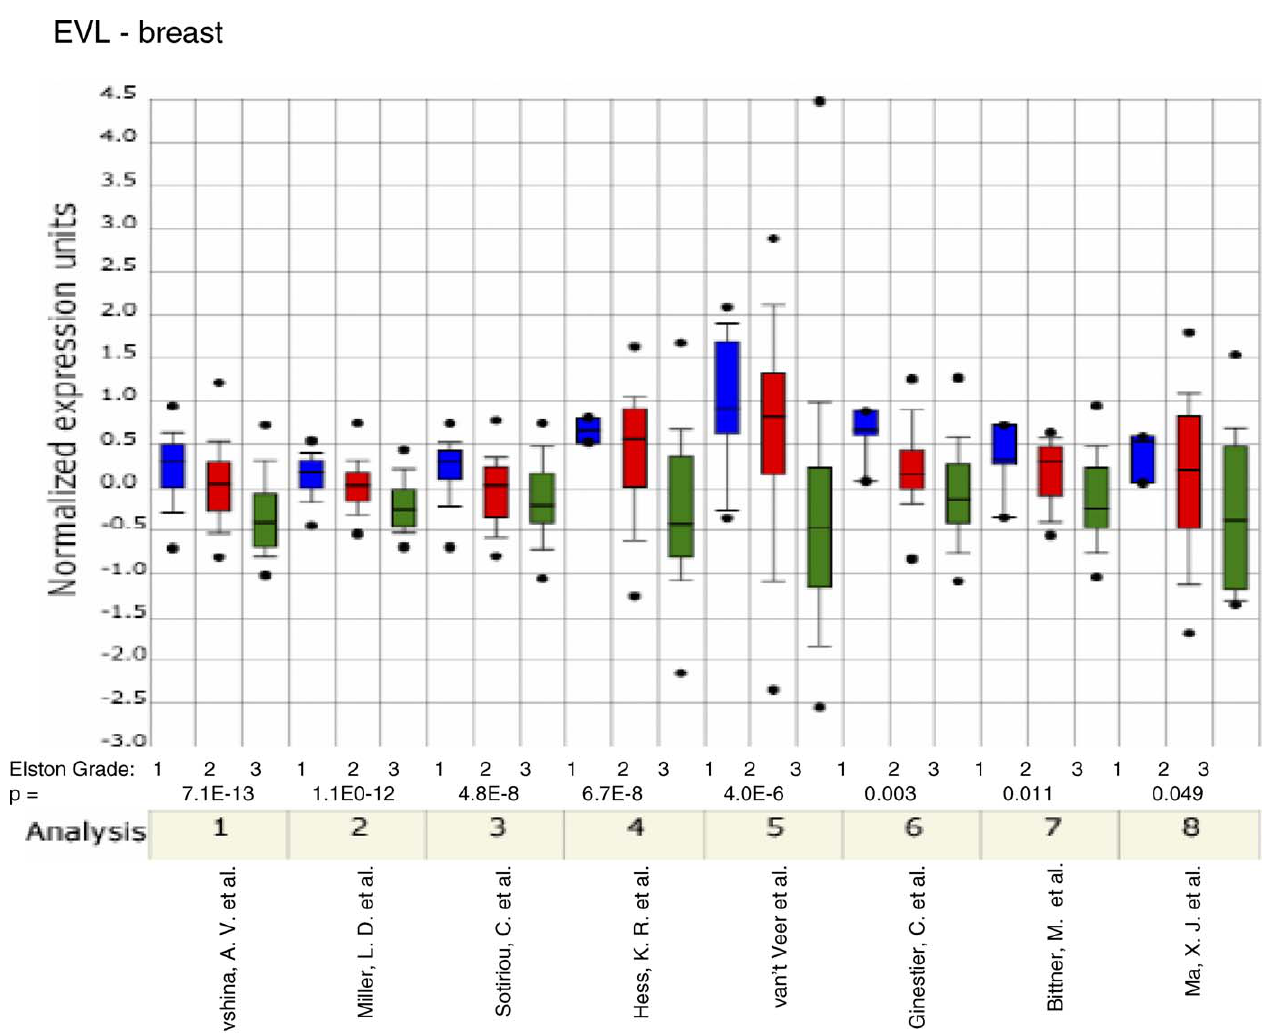
Figure 13. EVL Expression Is Decreased with Increasing Tumor Grade in Breast Carcinoma Representative data are shown across multiple independently published microarray studies as indicated. p -Values for correlation are shown below. References refer to those listed in Table